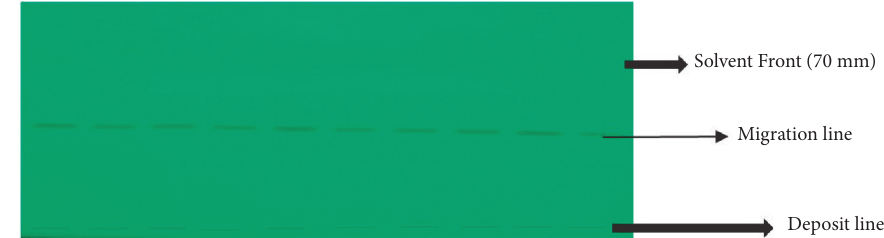
Figure 1: Chromatographic plate obtained with a mobile phase dichloromethane-methanol (9:1, v/v) and revealed at 254